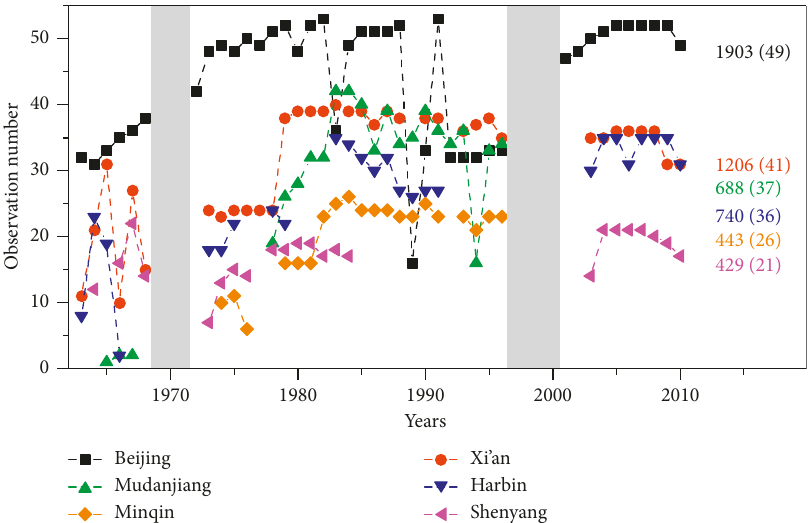
Figure 2: The numbers of phenological records at the six sites for each phenophase (leaf coloring date and full-leaf coloring date) during 1963–2010. The numbers at the end of the curves represent the total numbers of records for each phenophase. The numbers in the brackets are the number of species. The grey areas indicate the year lacking of observations.